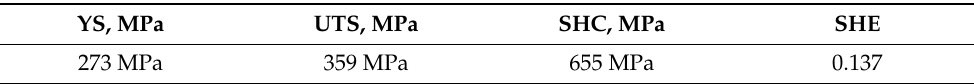
Table 2. Basic mechanical properties of CP grade 2 titanium sheet.